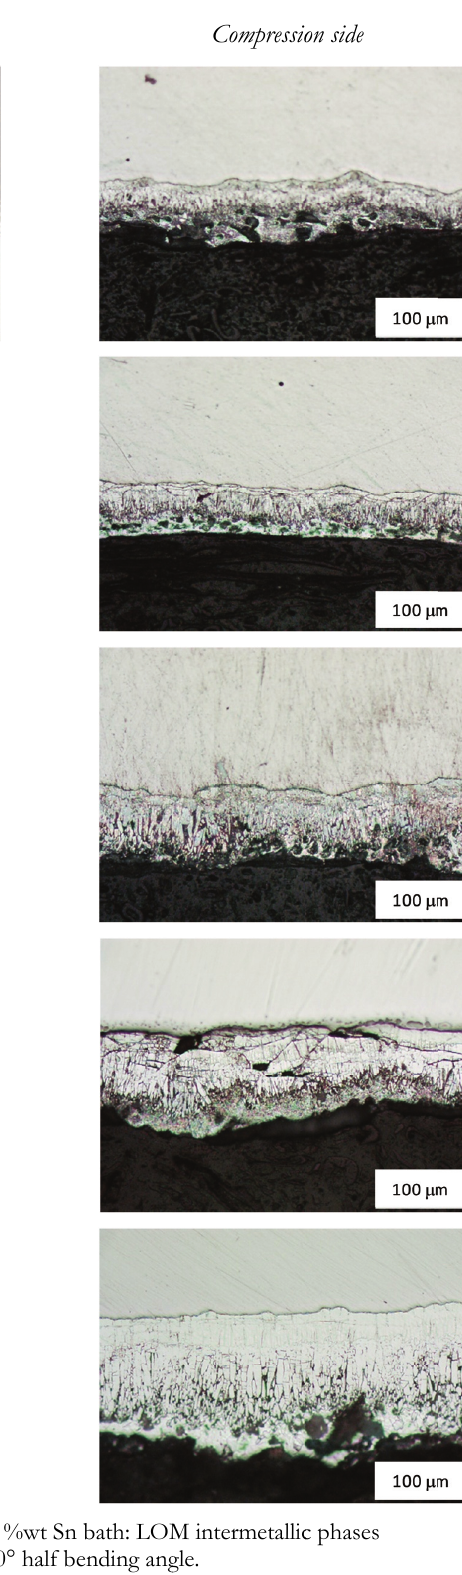
obtained using da amage morpho